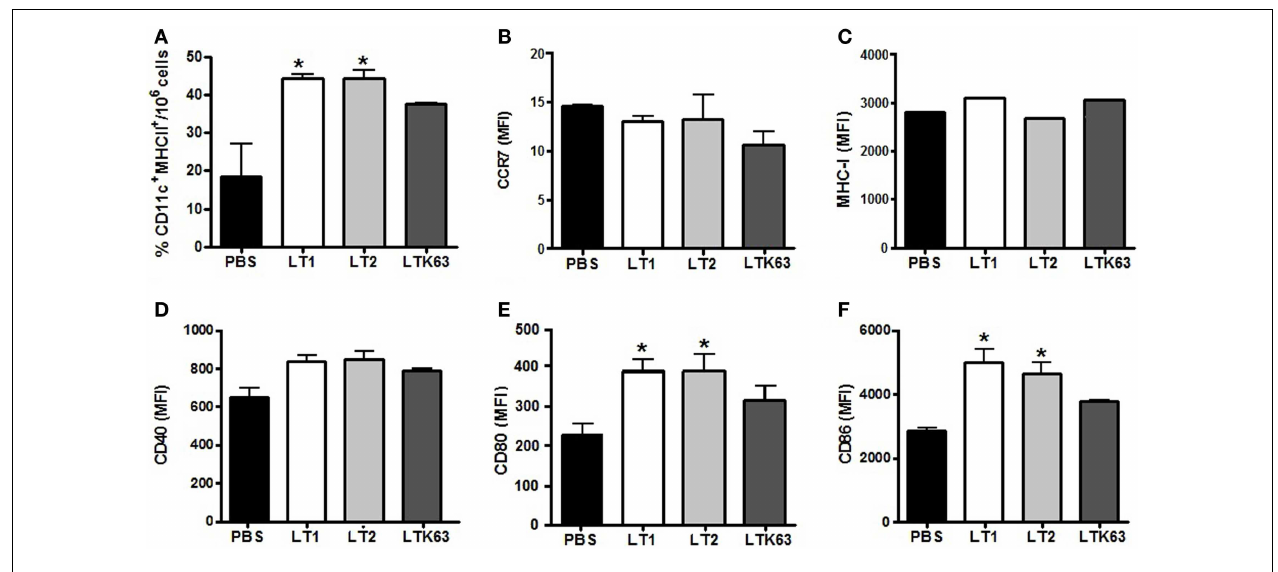
for (B) CCR7, (C) MHC-I, (D) CD40, (E) CD80, or (F) CD86 markers.The expression of surface markers was analyzed by acquiring 3 × 10 6 events. Asterisks indicate statistically significant differences (* p < 0.05) with regard to the control mouse group (PBS). Results are expressed as means ± SD of two experiments performed independently with pooled of ILNs cells harvested from mice ( n = 5) subjected to the different